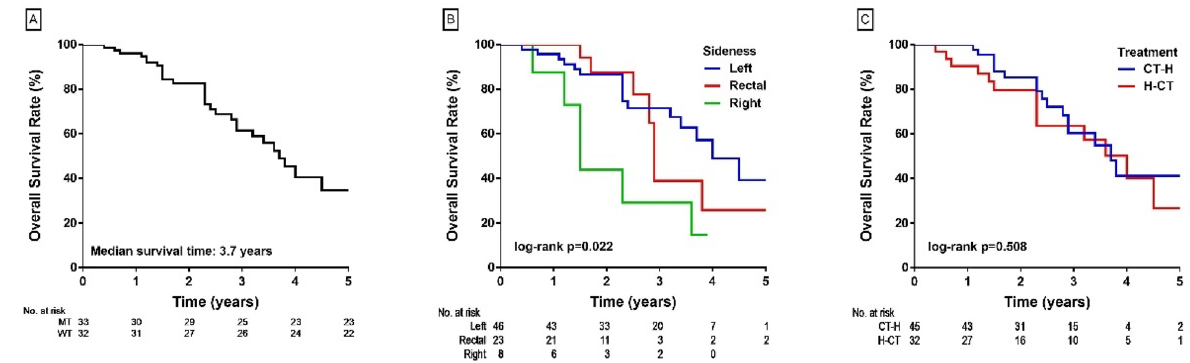
Figure 2. ( A ) Median survival time for all patients: 3.7 years. ( B ) Median survival time for the patients with left-sided tumors: 4 years; rectal tumors: 2.9 years; right-sided tumors: 1.5 years; ( C ) median survival time for the CT-H group: 3.7 years and H-CT group: 4.0 years.